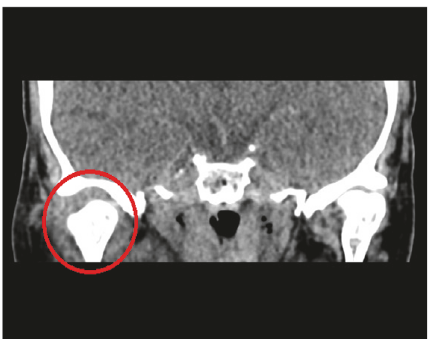
Figure 1: Coronal view.